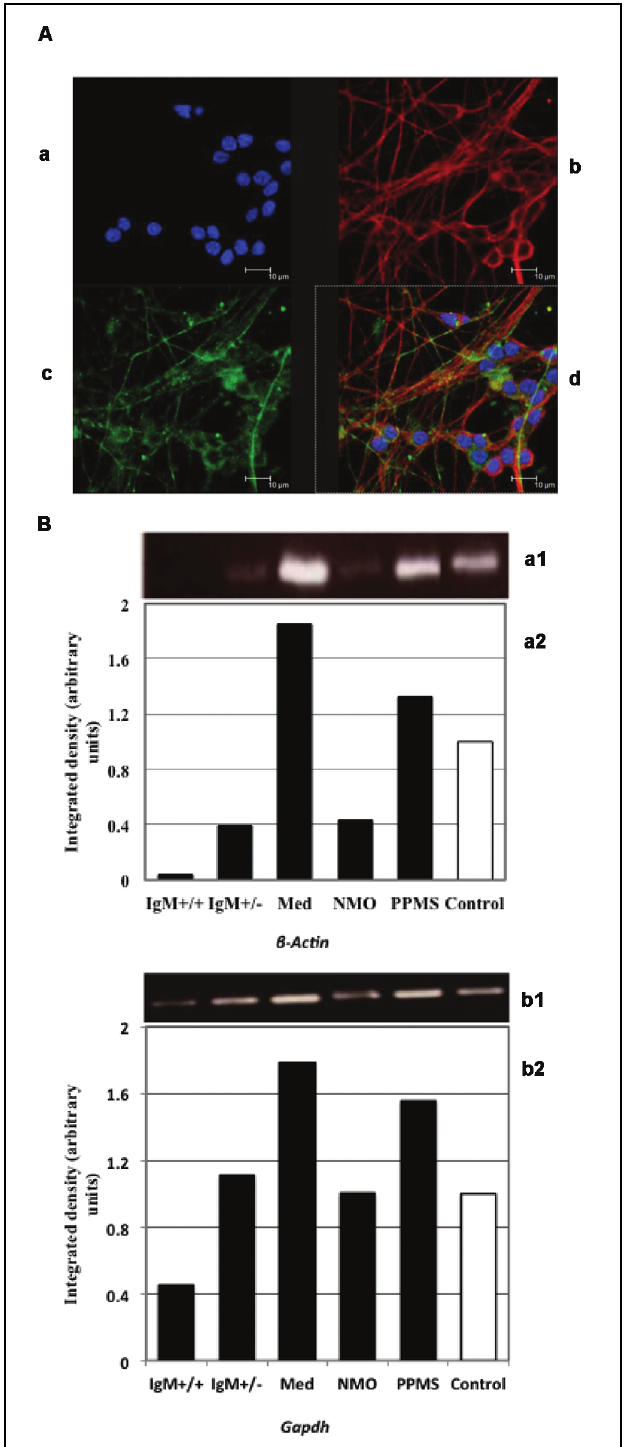
FIGURE 2 | (A) Immunofluorescence of primary cultures of CGNs. (a) DAPI stained nuclei. Neurofilaments stained with (b) Texas red and (c) FITC dyes. (d) Merged images. (B) Analysis of β -actin (a) and Gapdh (b) expression by PCR: (1) Electrophoretic bands; (2) Integrated density obtained by Image J software quantification. The values correspond with the fold change vs . control values of the MS clinical forms, NMO, and control patients.